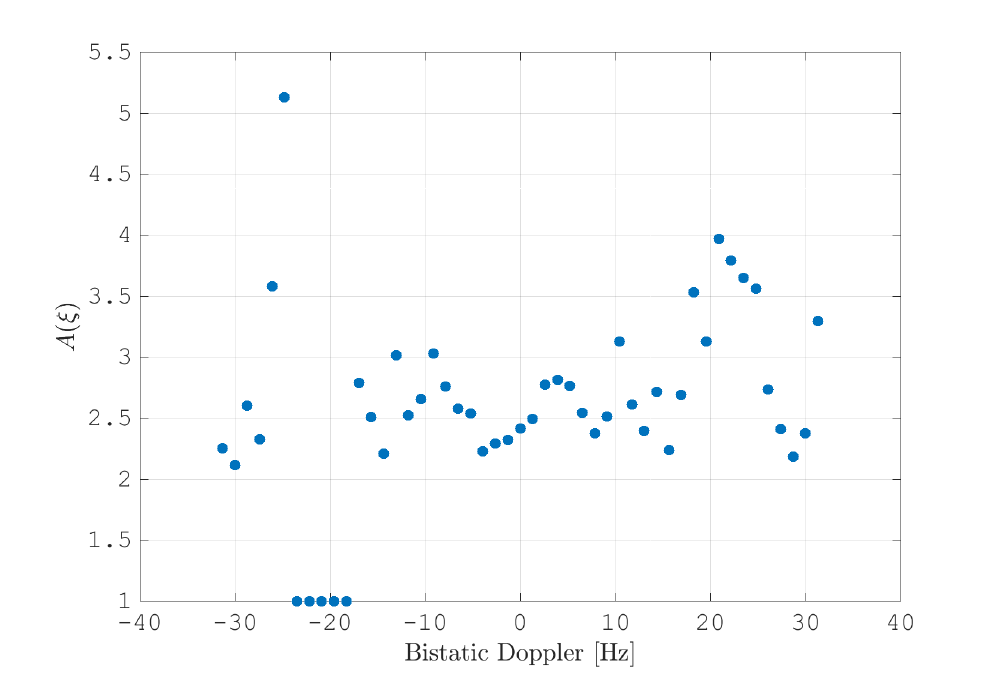
( Tx ) = − 11Hz D ( Tx ) were excluded D